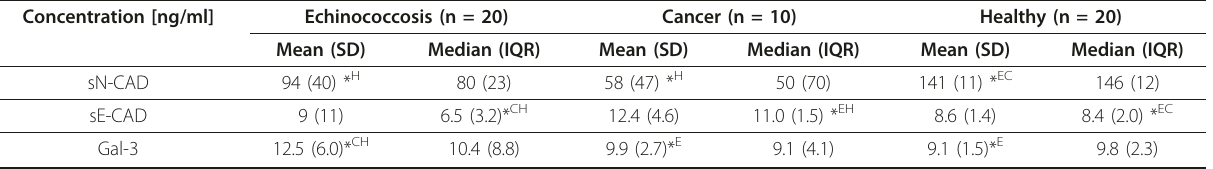
*- statistically significant differences ( p < 0.05) between the examined groups (E-echinoccocosis, C-cancer,